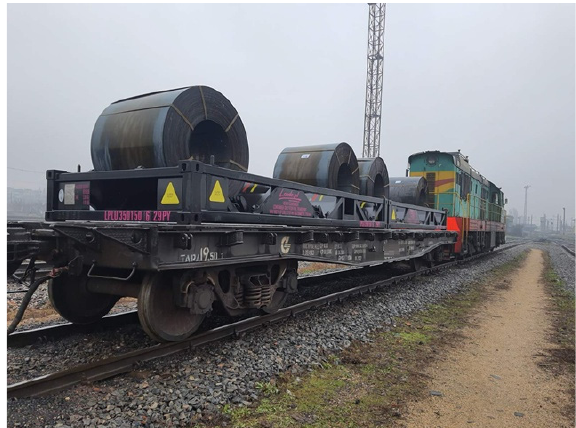
Figure 5. Flatcar loaded with coiled steel.